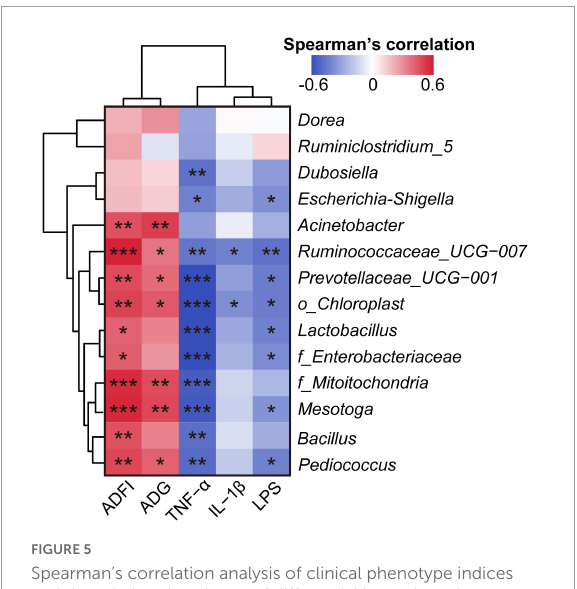
FIGURE5 Spearman’s correlation analysis of clinical phenotype indices and the relative abundance of differential bacteria at the genus level. * p < 0.05, ** p < 0.01, and *** p < 0.001. The Spearman’s correlation coefficient of significant correlations > 0.4 (or <